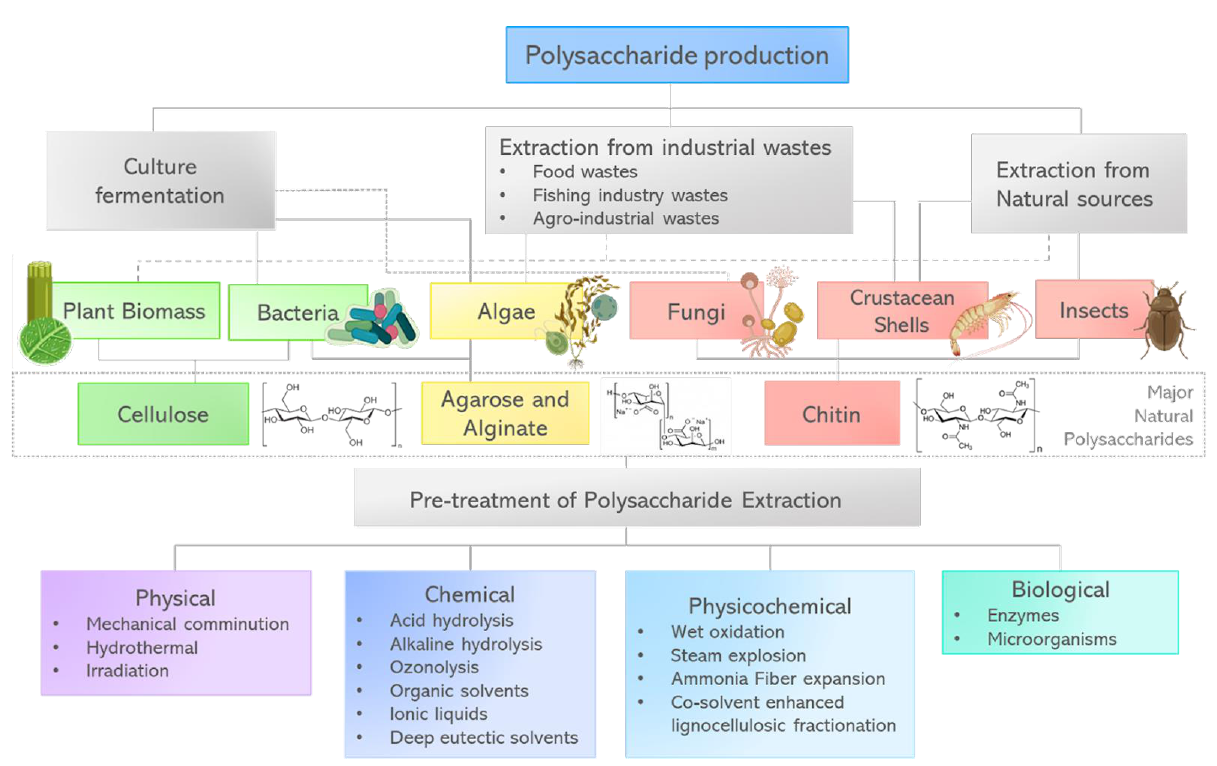
Figure 2. Major natural polysaccharides used in biomedical applications, highlighting their main sources, and the wide range of processes to isolate